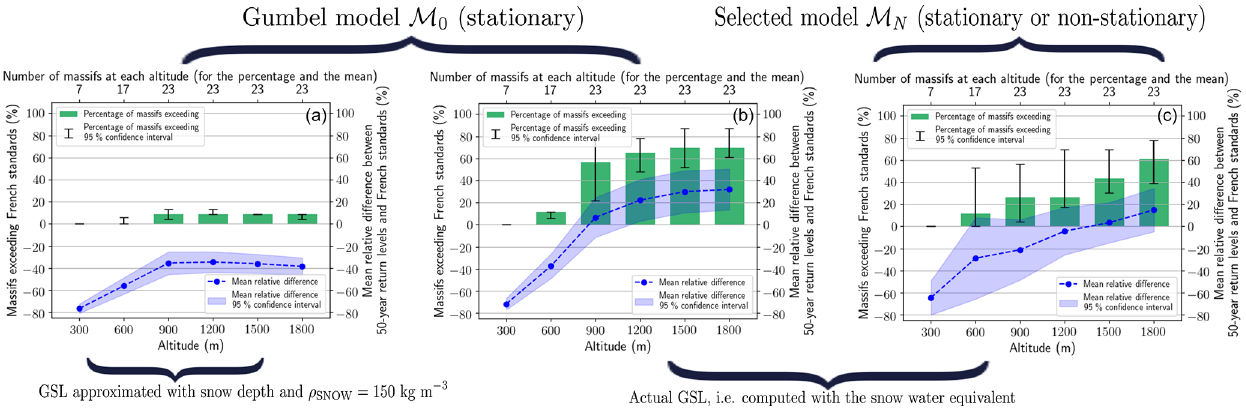
Figure 9. Comparison of 50-year return levels of ground snow load (GSL) with French standards between 300 and 1800m. We show the percentage of massifs (green histogram) whose return levels exceed French standards and the mean relative difference (blue line) between return levels and standards. (a) similar to French standards estimation (stationary Gumbel M 0 and GSL approximated with snow depth obtained from the reanalysis and ρ SNOW = 150kgm − 3 ). (b) stationary Gumbel M 0 and actual GSL, i.e. computed with SWE from the reanalysis. (c) selected model M N (if M N is non-stationary, the return level is the effective return level in 2019) and actual